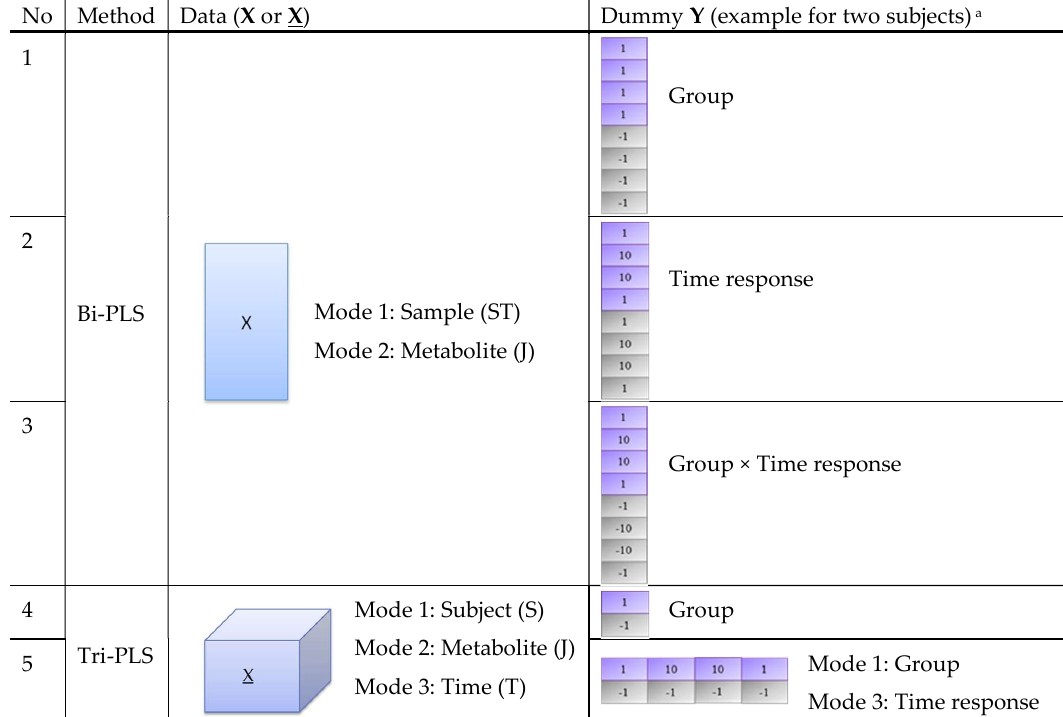
Figure 2. Structure of five PLS models for comparison. a The dummy Y in this figure is an example for data obtained from eight samples collected from two subjects at four time points (0, 2, 4, 24 h after intervention). Dummy Y in purple and grey colour corresponds to samples collected from Subject 1 (from intervention group) and Subject 2 (from the control group), respectively.